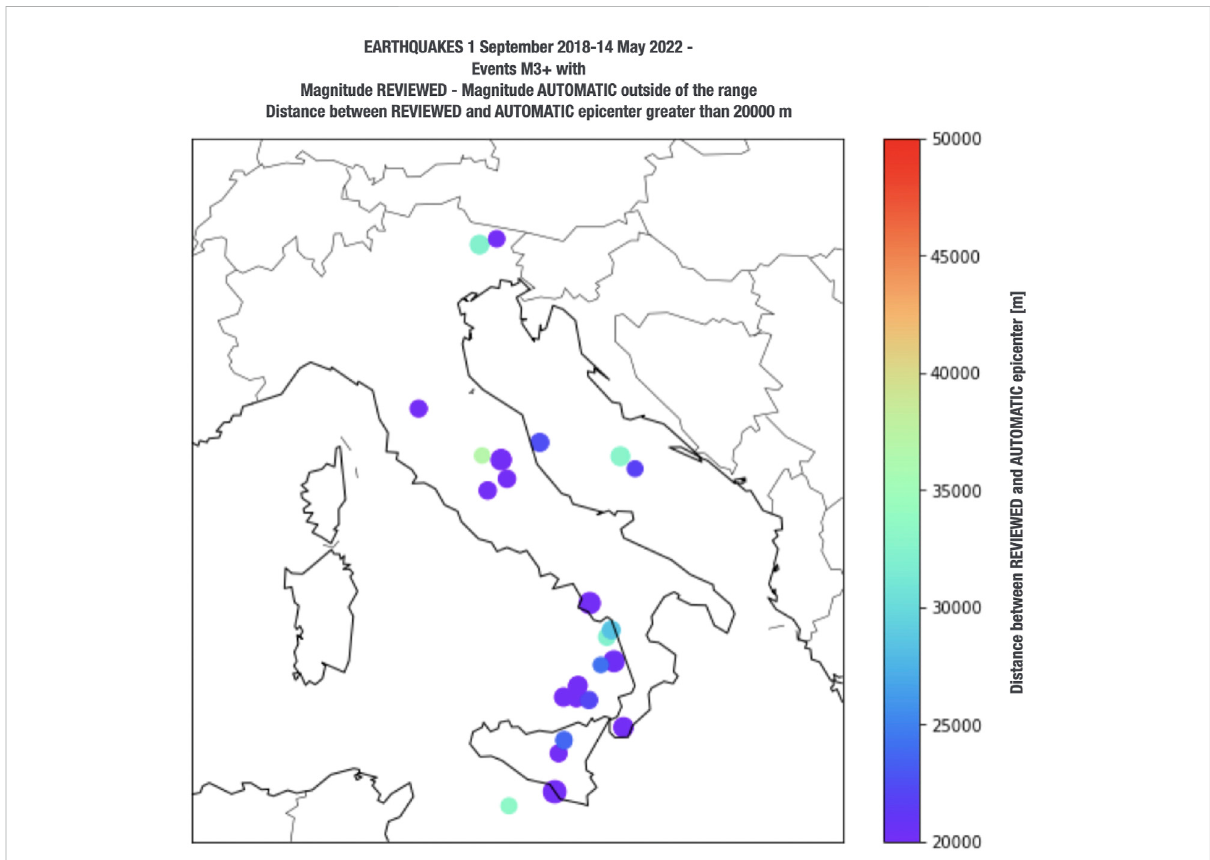
Geographical distribution of earthquakes (1 September 2018 – 14 May 2022) for which the revised parameters differed from those of the provisional estimate in a way that made the communication “ wrong ” (magnitude out of the uncertainty range and epicenter coordinates different more than 20